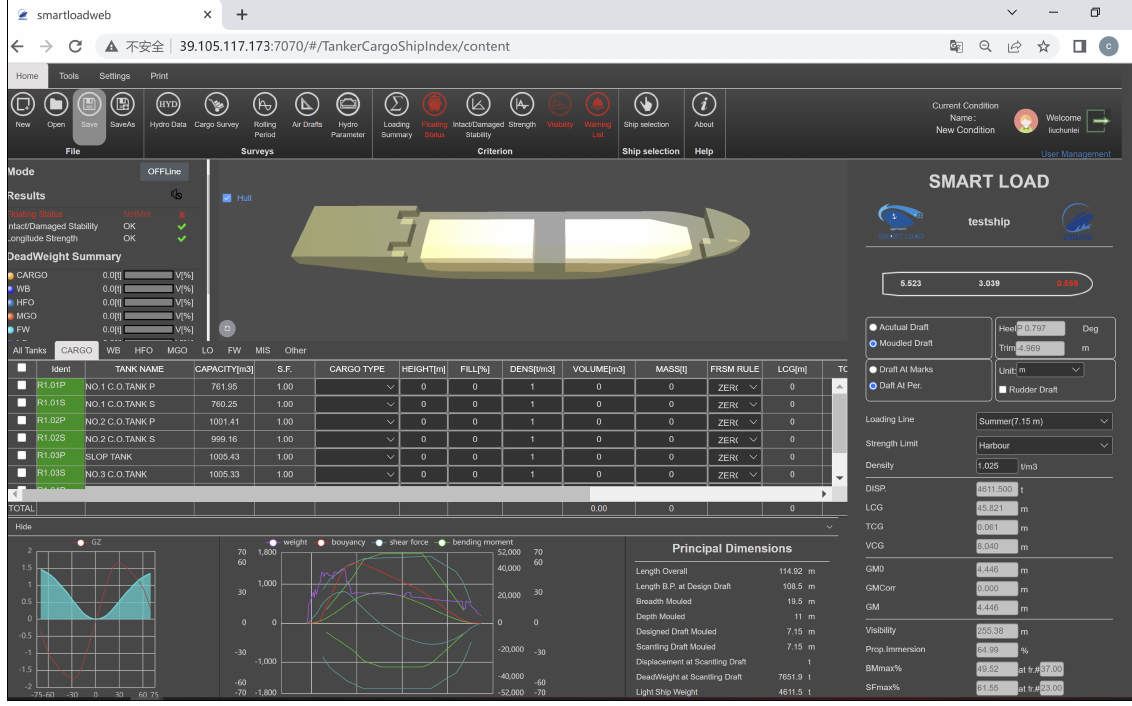
Figure 16. Web version of “SMART